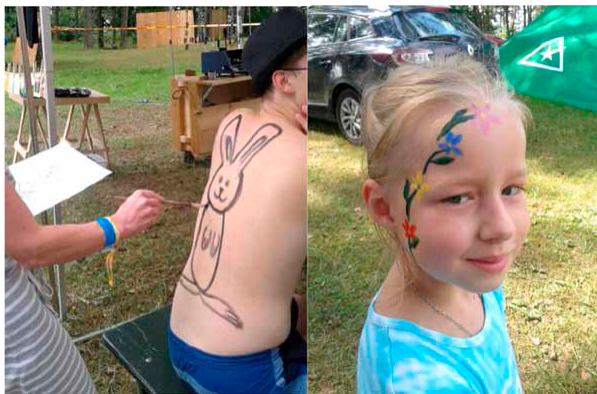
Figs. 2, 3. BEEpart project painting an animal on a volunteer’s body; ecological motives (children friendly animals and flowers) painted directly on backs, chests and faces of young participants of this workshop (Elena Sakalauskaitė’s